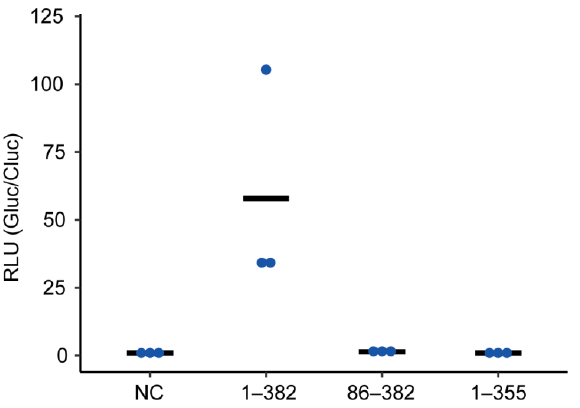
Figure 3. Minireplicon assay using truncated NYMV P. Minireplicon assay was performed on P mutants. The relative luciferase activities are indicated (biological replicates; n = 3). The line indicates the average, and blue dots represent individual data. NC, negative control; 1–382, full-length P; 86–382, P 86–382 ; 1–355, P 1–355 .